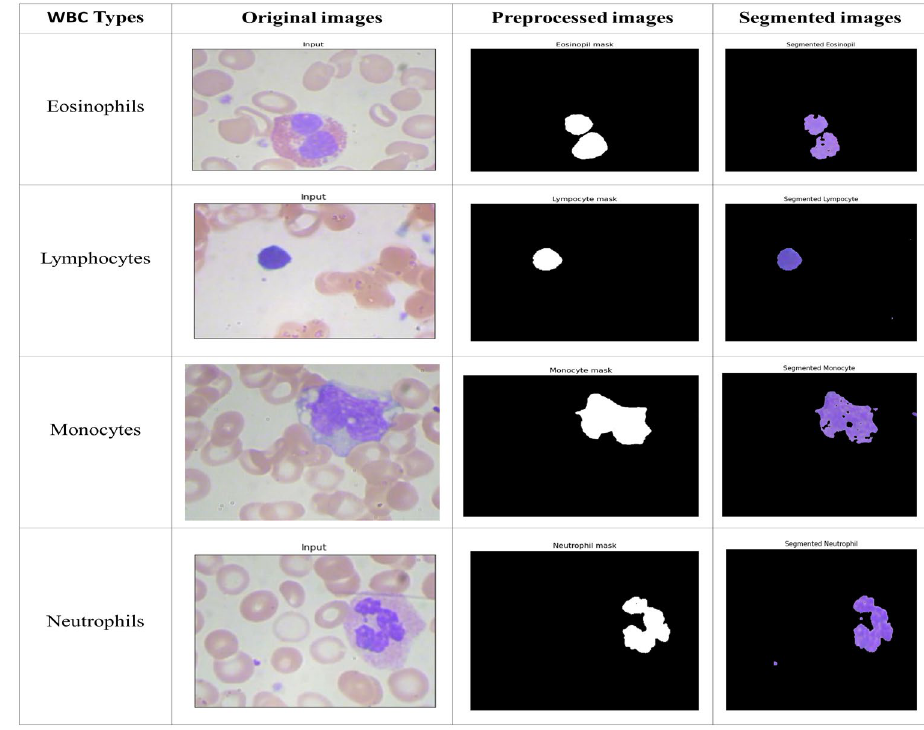
Figure 2. Visualization result on BCCD dataset.